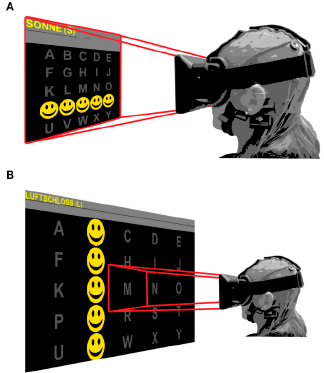
Figure 13. ( A ) Field of view for the glasses. In ( A ), the user sees the five-by-five matrix and the screen is fixed. In ( B ), the user can see only one letter from the five-by-five matrix, and the subject moves his head to concentrate on a specific letter [103].